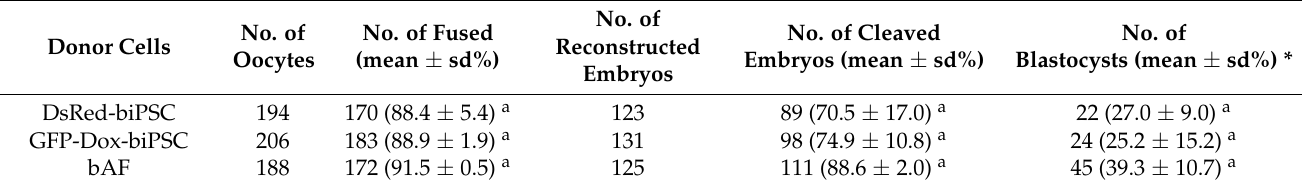
Figure 5. Mouse embryo chimerism analysis of biPSCs. ( A ): DsRed-biPSCs incorporation of mouse blastocyst (right) at 24 h after embryo aggregation. Bar = 60 µ m. ( B ): DsRed-biPSCs contribution to the decidua of #4 (right) but not #1 (left) E8.5 mouse embryo. Bar = 625 or 250 µ m as indicated. ( C ): PCR analysis of DsRed-biPSC contribution in E8.5 mouse decidual tissue (upper panel) and embryo proper (EP, lower panel) using bovine-specific primers. ( D ): PCR analysis of DsRed-biPSC contribution on E8.5 embryos using pMXs-vector primers (upper panel). PCR using mouse-specific primers (lower panel) served as reference. Table 1. Fusion Rates and In Vitro Developmental Capacities of Cloned Bovine Embryos Generated Using biPSCs as Nuclear